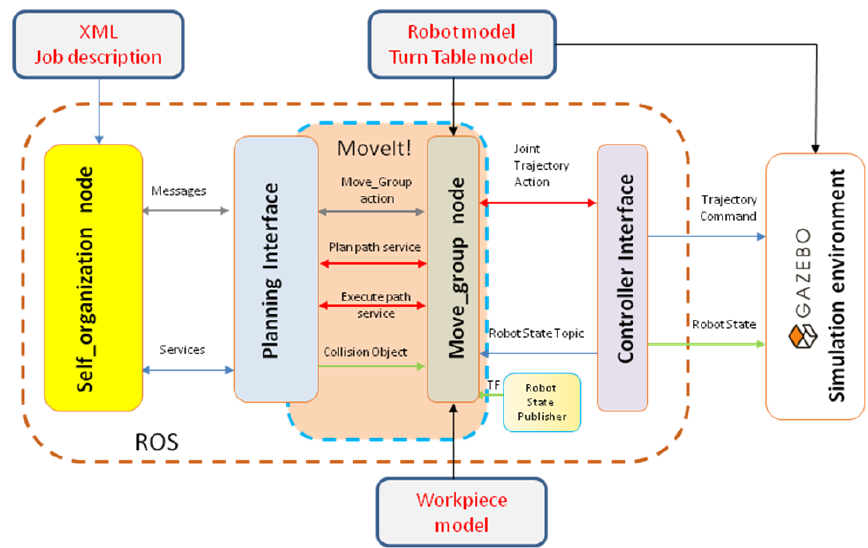
Figure 7. IT infrastructure for autonomous planning, self-organization, and control of collaborating robots in executing welding jobs though teamwork.